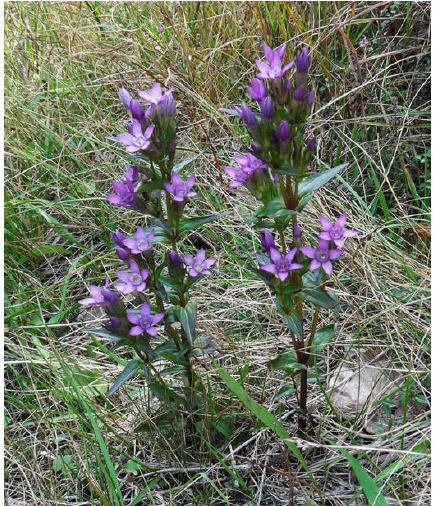
Figure 1. Gentianella lutescens subsp. carpatica in a natural habitat on Povlen mountain (locality Razbojište), Serbia.